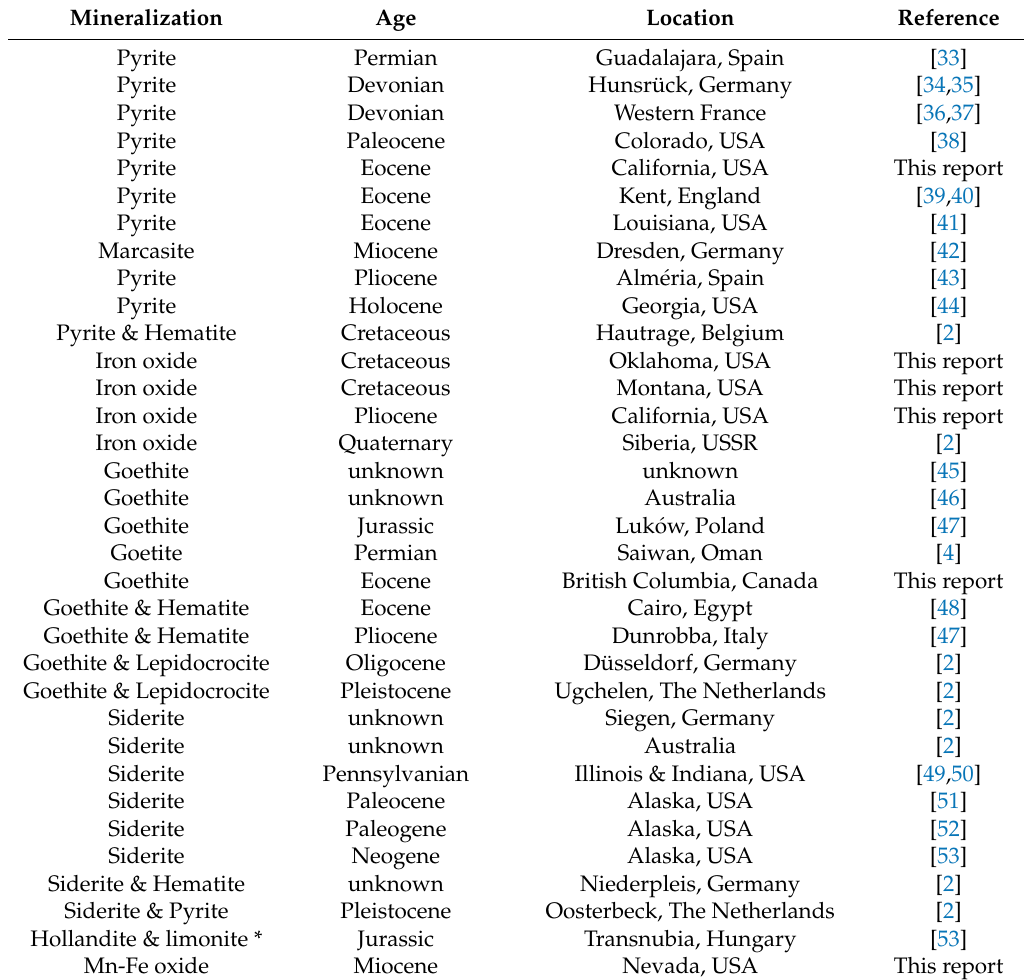
Table 4. Woods mineralized with iron or